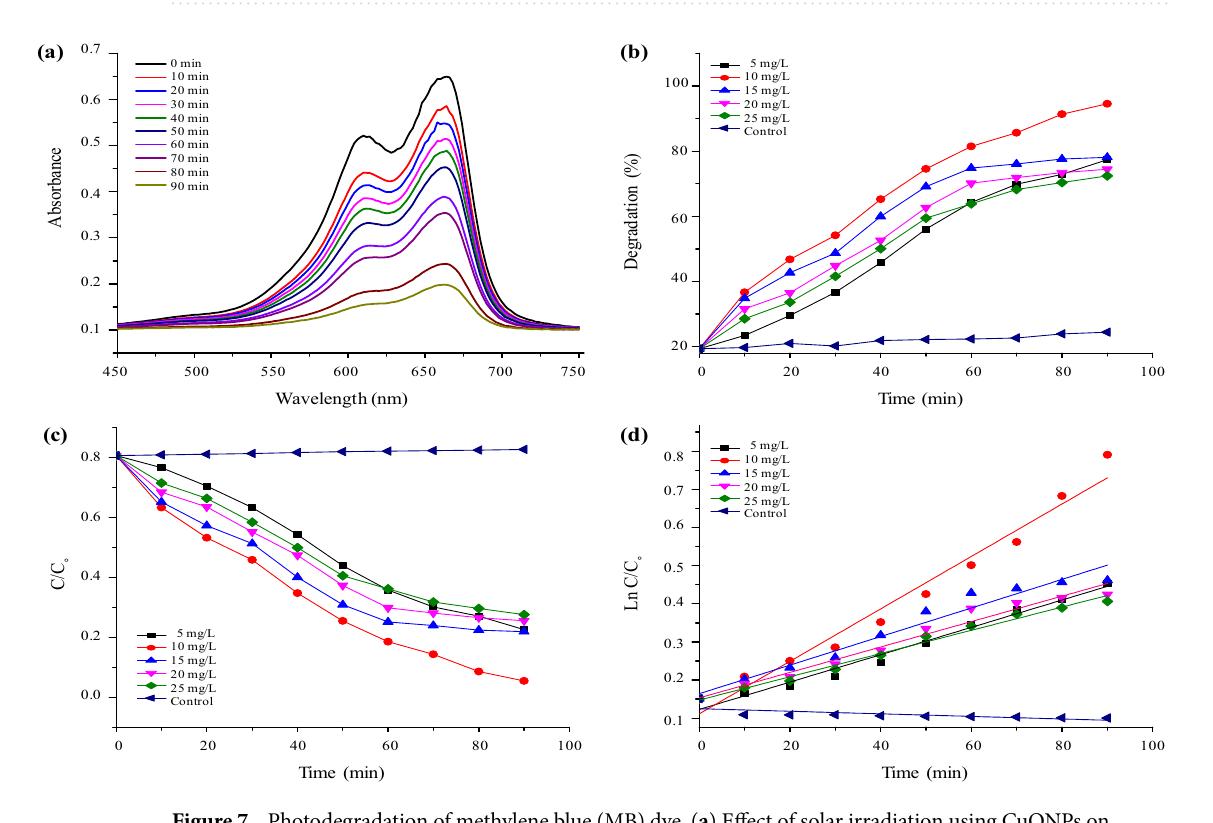
Figure 7. Photodegradation of methylene blue (MB) dye, ( a ) Effect of solar irradiation using CuONPs on photocatalytic degradation of MB dye; ( b ) Percent photocatalytic degradation of MB dye as effect of time with varying photocatalyst (CuONPs) load; ( c ) Photodegradation of dye versus irradiation time at varying photocatalyst (CuONPs) measured by optical absorption; ( d ) Plot of ln(C 0 /C) versus irradiation time for dye degradation